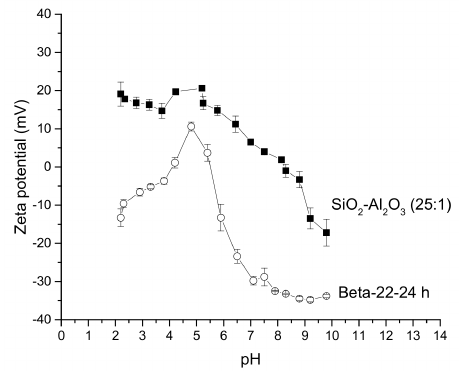
Figure 6. Zeta potential curves as a function of pH for a physical mixture SiO 2 -Al 2 O 3 with a molar ratio of 25:1 and for an amorphous zeolite mixture with silica to alumina ratio of 22 aiming for Beta zeolite structure, synthesized for 24 h. Conditions: 2 mg/mL, 25 ◦ C.